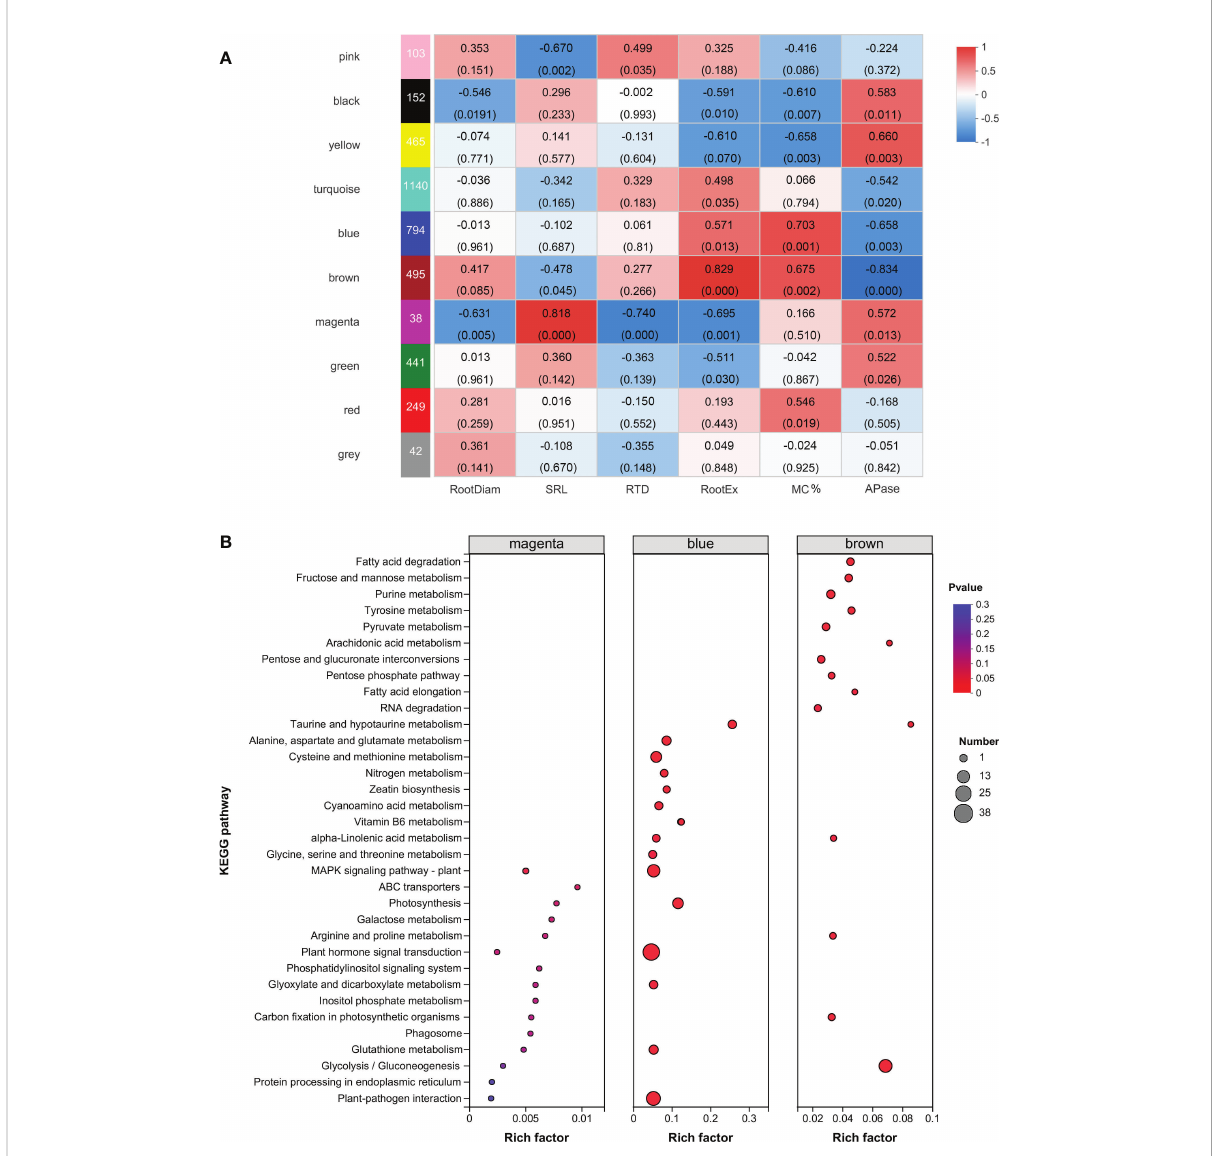
FIGURE 4 Identi fi cation of modules involved in the acquisition of root phosphorus. (A) Weighted Gene co-Expression Network Analysis (WGCNA) of deferentially expressed genes. On the left side, ten modules are displayed. p-values are shown in parentheses. The color scale on the right side shows module-trait correlation from − 1 (blue) to 1 (red). (B) KEGG enrichment analysis of sample-speci fi c modules. The color and size of the circle indicate the signi fi cance level (P value) and the number of target genes involved, respectively. Root trait abbreviations: RootDiam, average diameter of roots; SRL, speci fi c root length; RTD, root tissue density; RootEX, the amount of carboxylates in the rhizosheath; MC%, colonization by arbuscular mycorrhizal fungi; APase, acid phosphatase activity in the